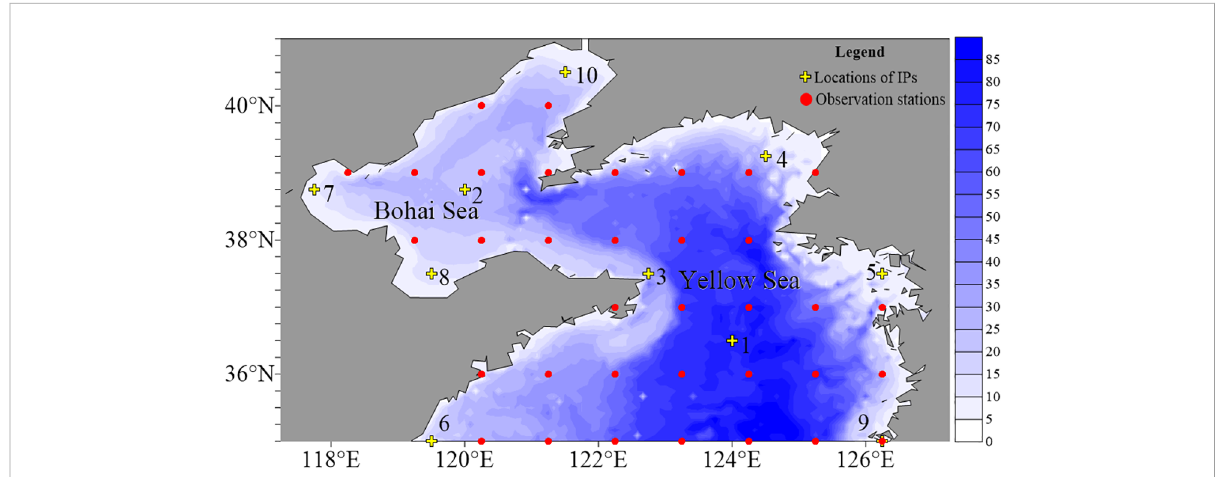
FIGURE 2 The locations of independent points (IPs; marked with yellow crosses) and the observation stations in EXP 1 to EXP 5 (marked with red dots) for bottom friction coef fi cient (BFC)